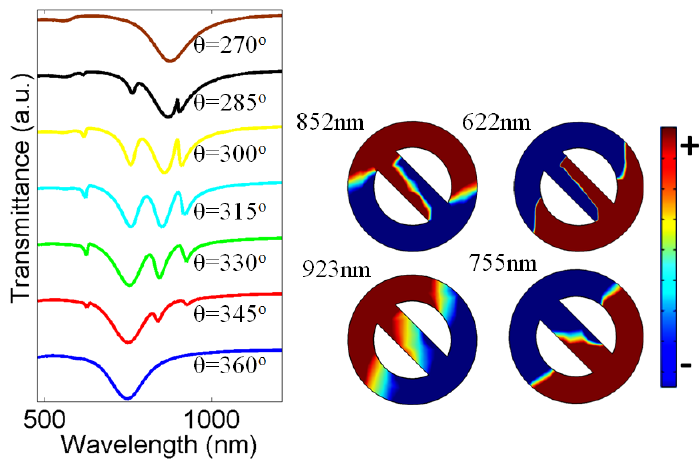
Figure 3. Transmittance spectra of theta ‐ shaped metasurface at different values of θ . Inset shows surface charge distributions at θ = 315 ° .